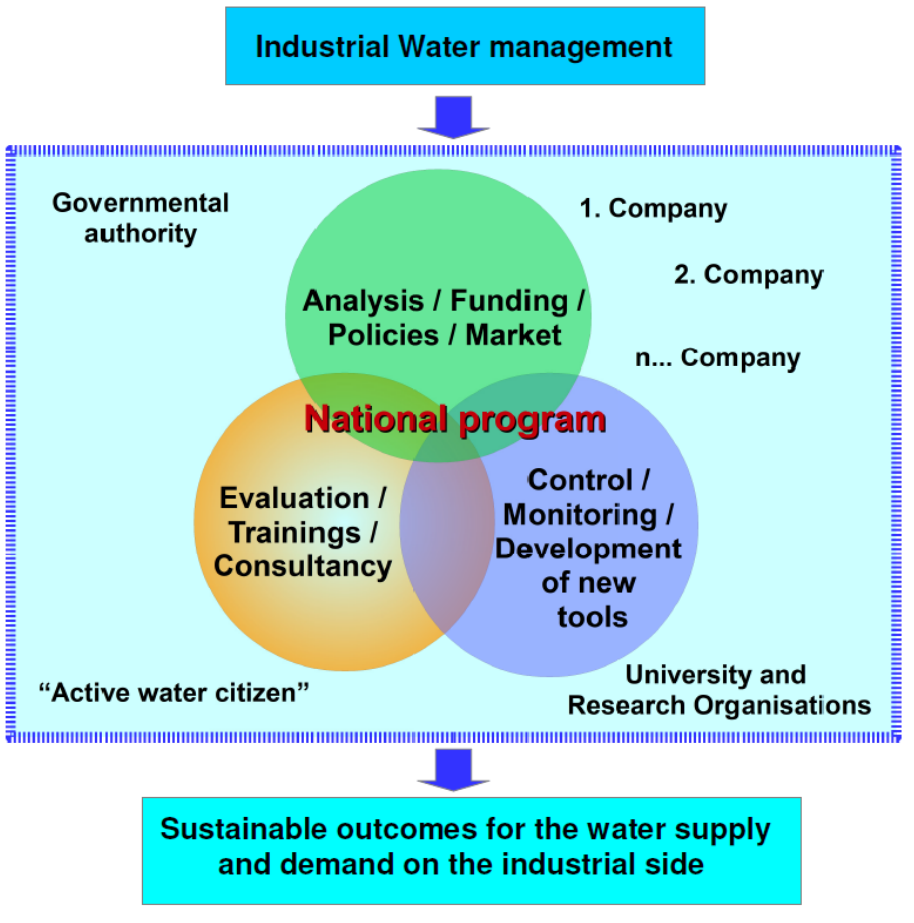
Figure 6. Recommendation for the industrial water supply–demand framework.